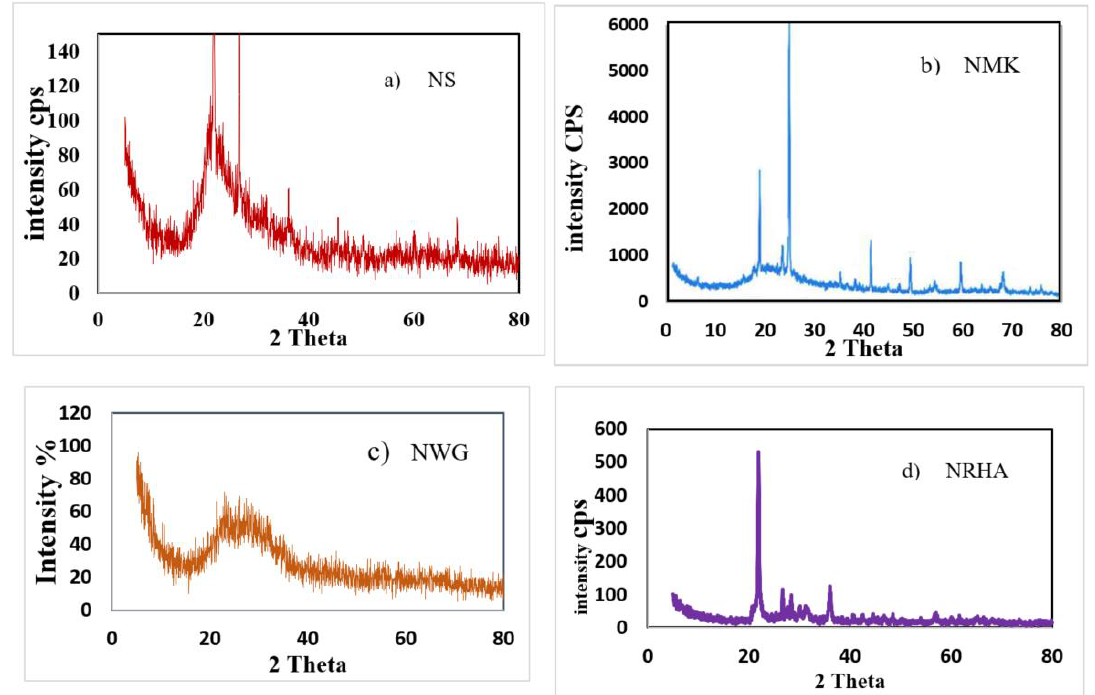
Figure 2. X-ray diffraction pattern of different types of nanoparticles.